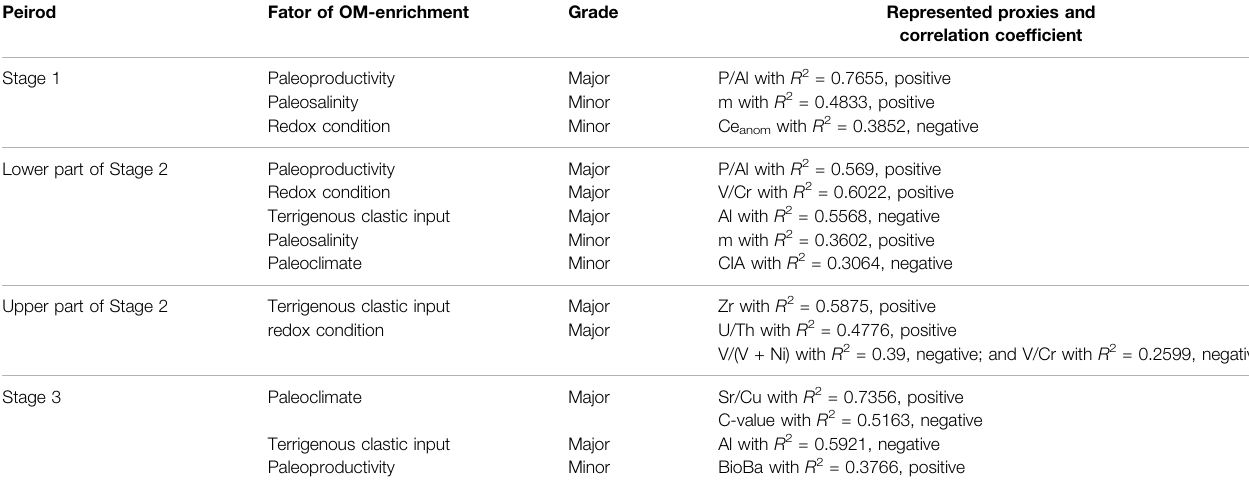
TABLE 1 | Factor of OM-enrichment in different